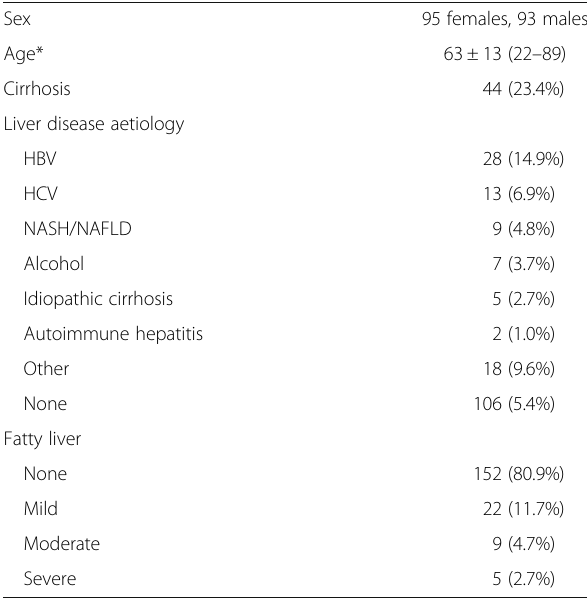
Table 2 Patient demographics and clinical